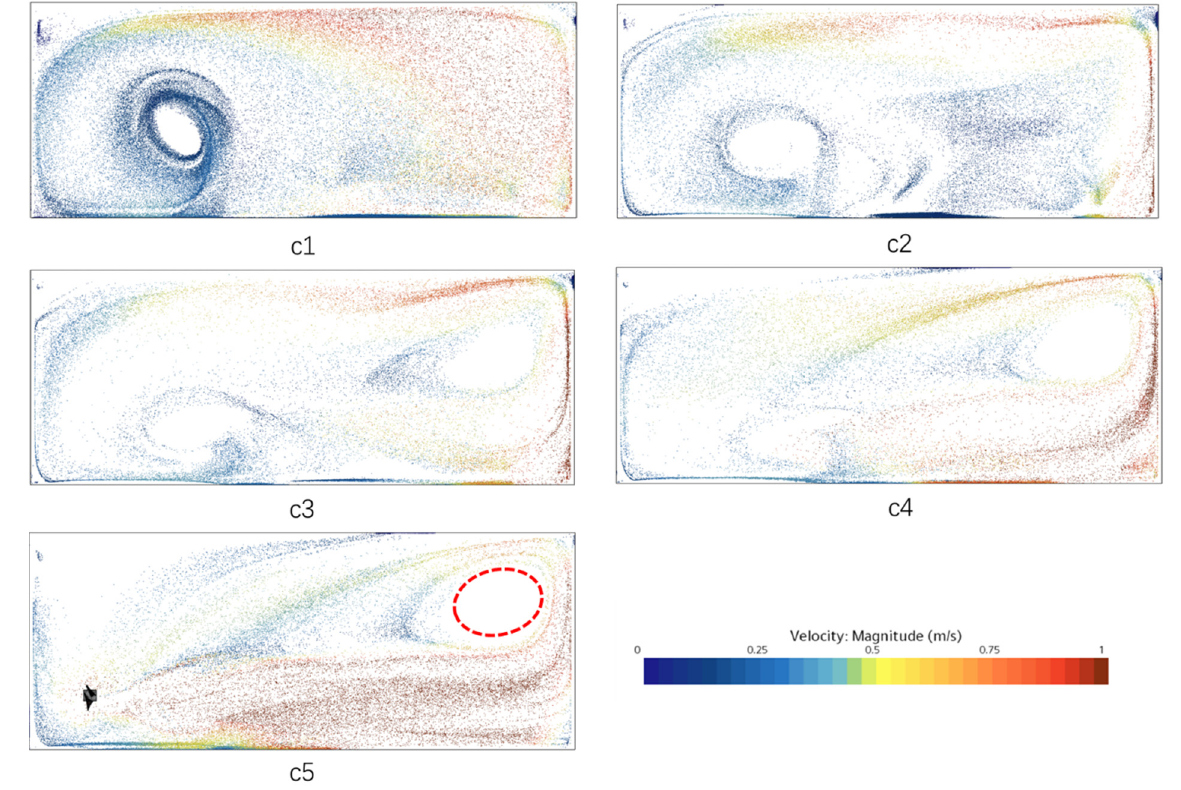
Figure 23. Location and velocity distribution of particles in c1~c5.